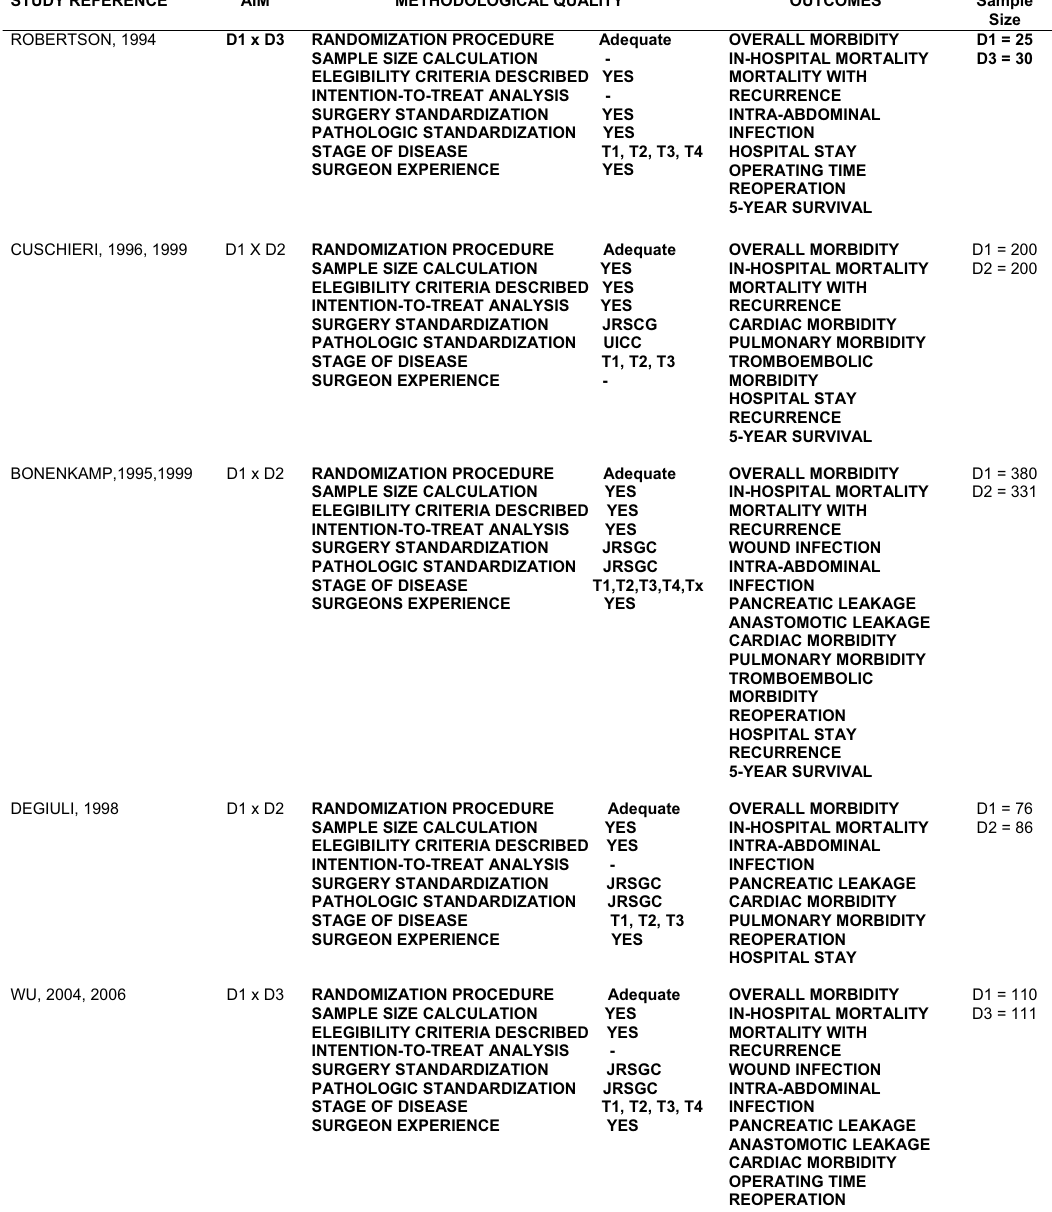
TABLE 1 - Characteristics of the RCTs included in the